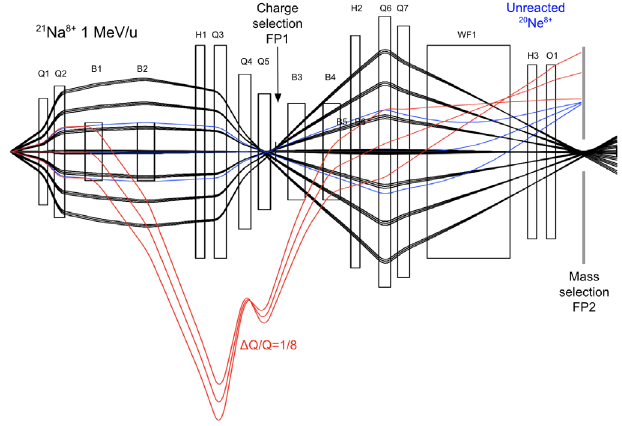
FIG. 1. COSY Infinity ion optics calculation (x-plane only) of a proton-capture reaction on 20 Ne 8 þ . SECAR elements are shown up to the first mass separation slits. The recoils ( 21 Na 8 þ ) are shown in black for different outgoing energies and angles, recoils of charge Q ¼ 9 þ are shown in red, and unreacted 20 Ne 8 þ of similar magnetic rigidity is shown in blue.